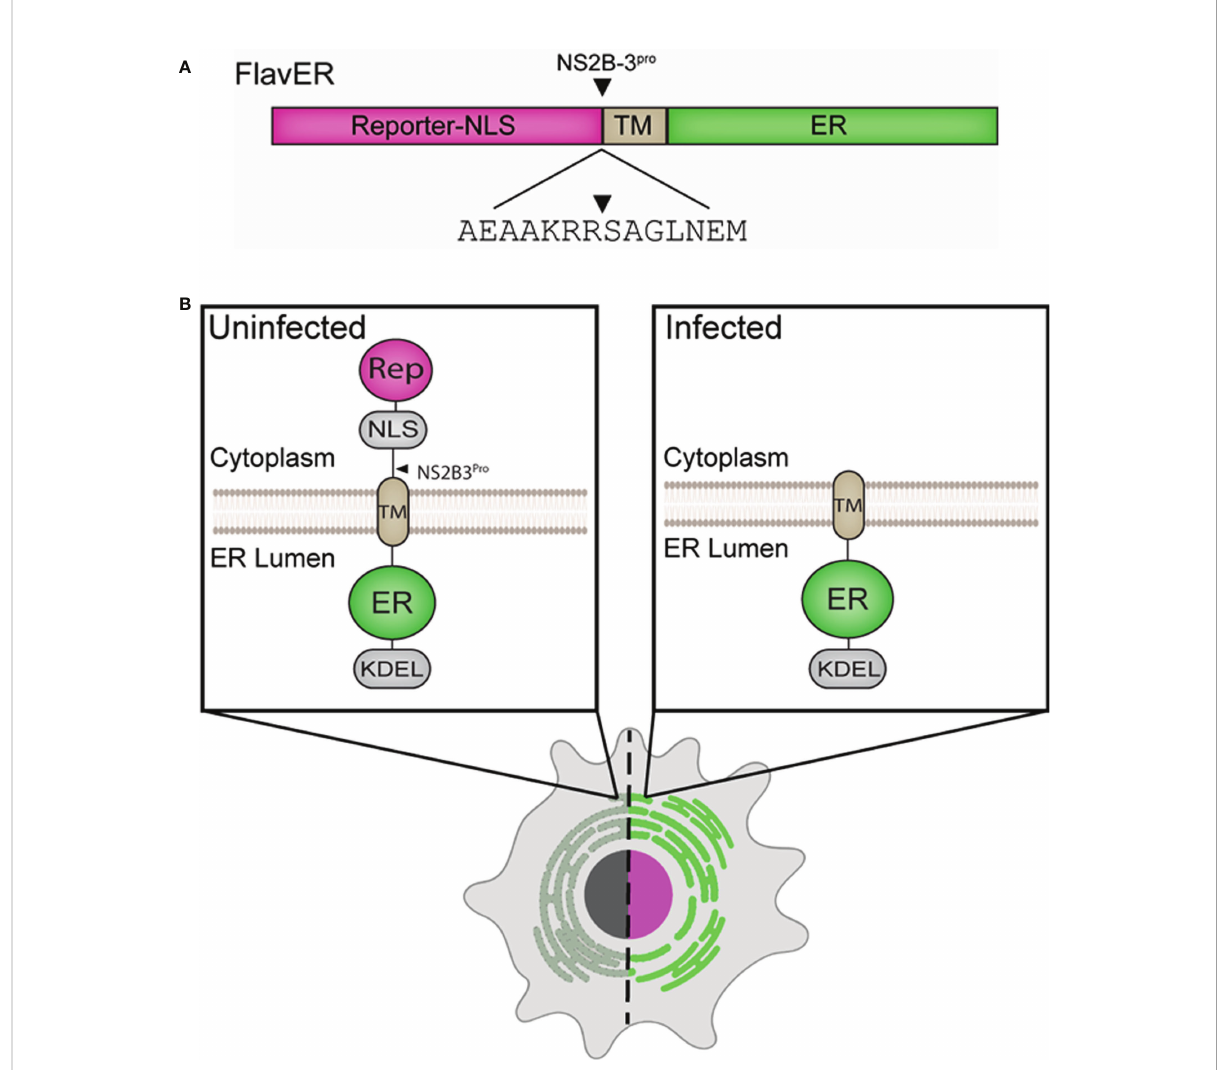
FIGURE 1 Design of an ER and fl avivirus infection reporter. (A) Linear model of FlavER. The FlavER reporter consists of a fl uorescent protein infection reporter fused to a nuclear localization sequence (NLS) followed by a consensus viral protease (NS2B3) cleavage sequence fused to a transmembrane domain (TM) followed by a fl uorescent protein ER marker. Black triangle represents the site cleaved by the viral protease. (B) Proposed model of FlavER function. In uninfected cells (left), the reporter signal and ER marker colocalize at the ER. During fl avivirus infection (right), viral NS2B3 cleavage releases the reporter signal, which then translocates to the